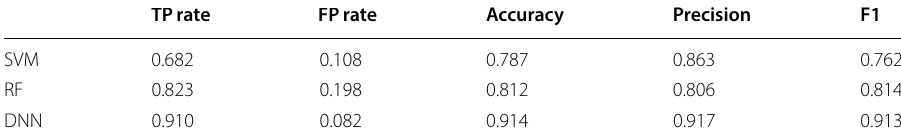
Table 6 Results reproduced from [18], abbreviations are as follows: Support Vector Machine (SVM); Random Forest (RF); Deep Neural Network (DNN); true positive ( TP ); false positive ( FP ); F1 score